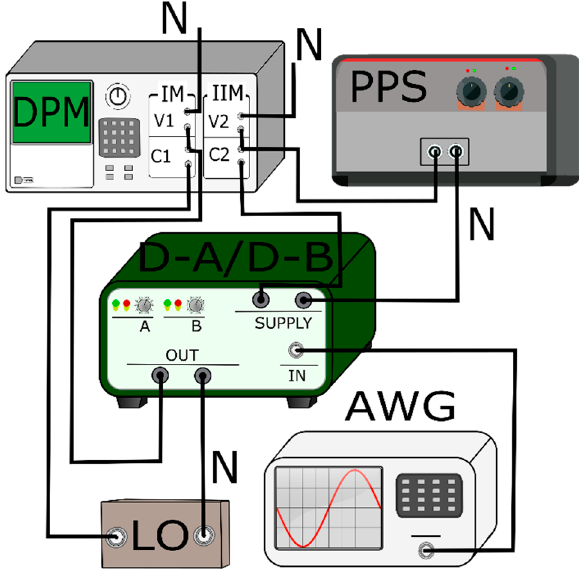
Figure 10. Measuring circuit used to determine the rms values of harmonics in supplying current of wideband power